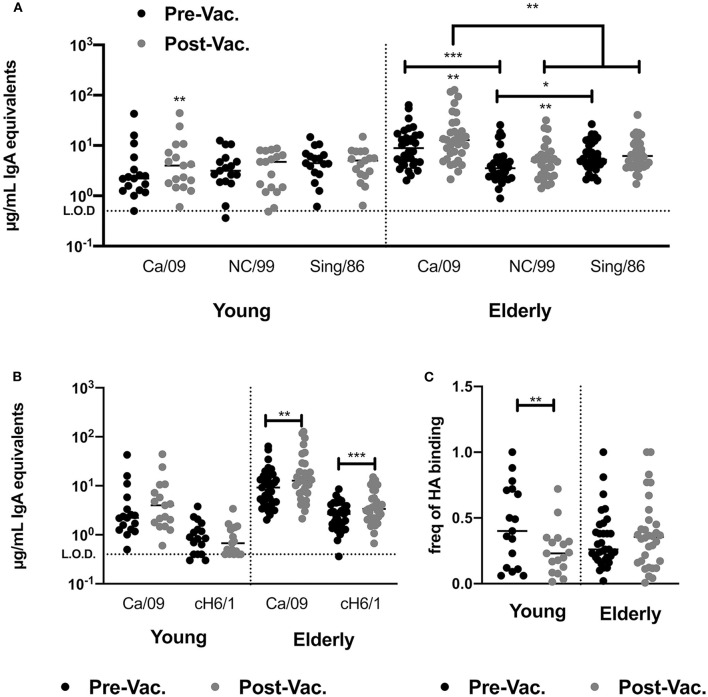
IIV vaccination does not recall broadly reactive IgA antibodies in young and elderly subjects. (A) Levels of HA-reactive IgA antibodies against rHAs from three H1N1 influenza viruses (CA/09, NC/99 and Sing/86) in the serum of young adults and elderly subjects prior to and post-vaccination. (B) Level of H1 stem-directed IgA antibodies in the serum of young adults and elderly subjects prior to and post-vaccination, measured by ELISA as described in the M&M section. (C) Frequency of stem-directed IgA antibodies relative to total rHA binding, in the serum of young adults and elderly subjects prior to and post-vaccination. *p < 0.05, **p < 0.01, ***p < 0.001.